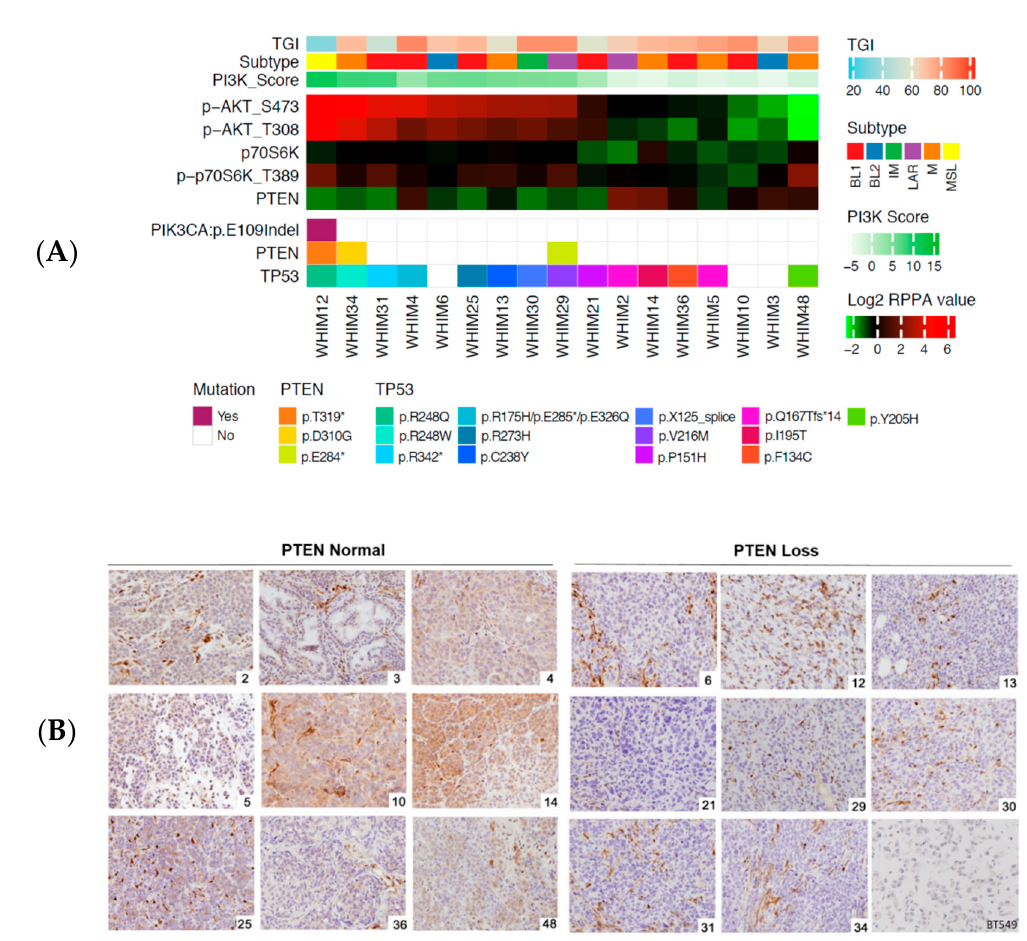
Figure 1. Genomic characterization and proteomic analysis of PI3K pathway. Panel ( A ) shows the heatmap illustrating somatic mutations of TP53 and key PI3K pathway genes, TNBC subtypes (of later passage PDX), and quantitation of selected PI3K pathway downstream signaling components by RPPA. PI3K_Score is the sum of the phosphoprotein levels of Akt, mTOR, GSK3, S6K, and S6, minus the total levels of pathway-inhibitor PTEN, as previously described (9). TGI, % tumor growth inhibition by BKM120 compared to vehicle, is also indicated for each PDX model to contrast with the baseline tumor characteristics. Panel ( B ) shows representative pictures of IHC for PTEN for each PDX model (WHIM number is located at the right lower corner of each picture). PTEN null or loss is observed in WHIM6, 12, 13, 21, 29, 30, 31, 34. PTEN expression is observed in WHIM2, 3, 4, 5, 10, 14, 25, 36, 48. PDX ID corresponding to WHIM numbers are annotated at the right lower corner for each model. Staining for BT549 (PTEN null negative control) is also included. MCF7 was used as positive control for PTEN IHC.